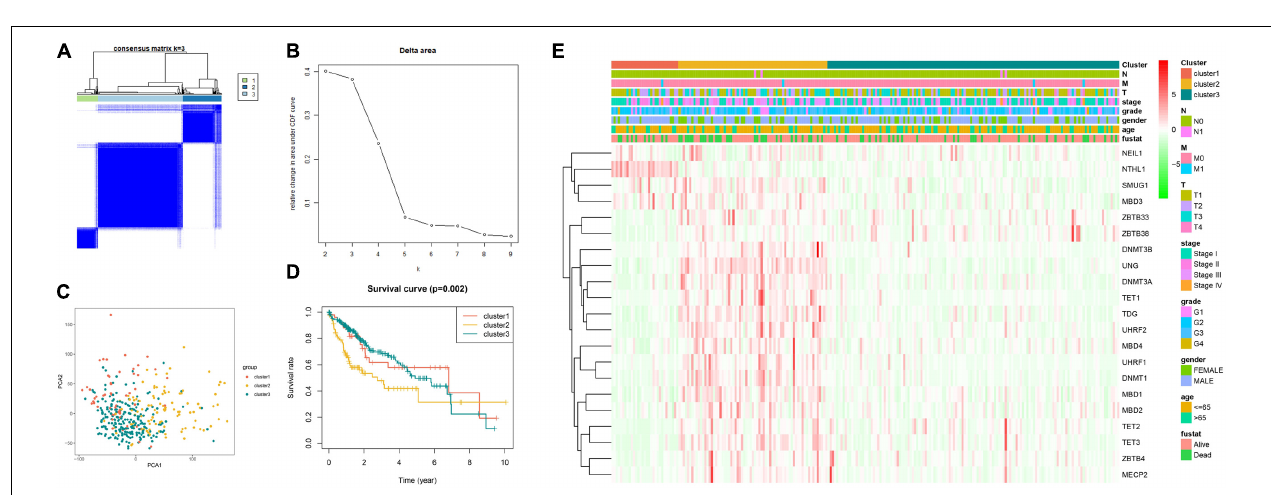
FIGURE 3 | Establishment, verification, and heatmap of 5mC related molecular subtypes. Panels (A,B) show the most appropriate value for cluster. (C) Results of PCA. (D) Survival analysis. (E) Heatmap of subtypes.